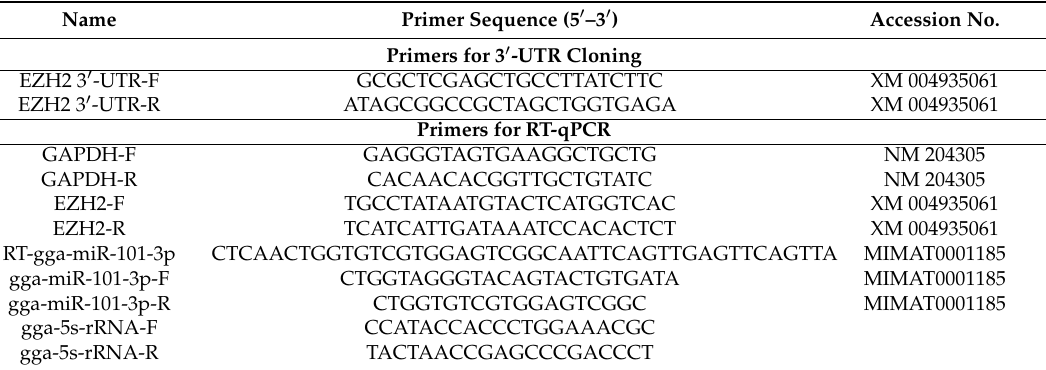
Table 1. Sequences of DNA